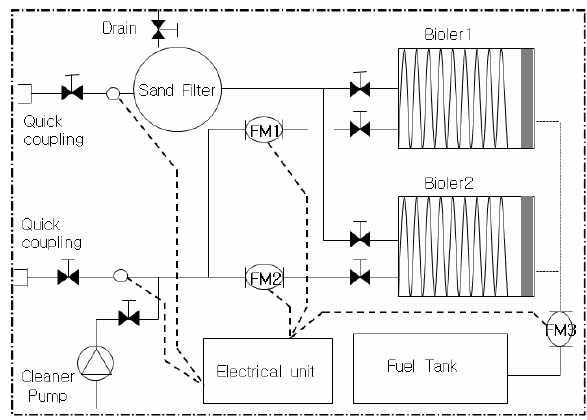
Figure 3. Experimental apparatus of a standing column well (SCW) system.